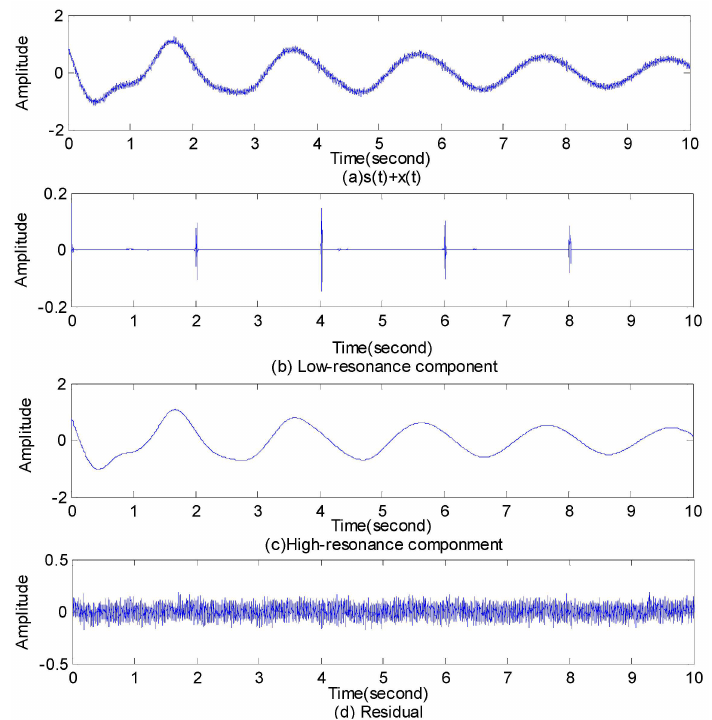
Figure 6. RSSD of the simulated signal with transient impulse and white noise.